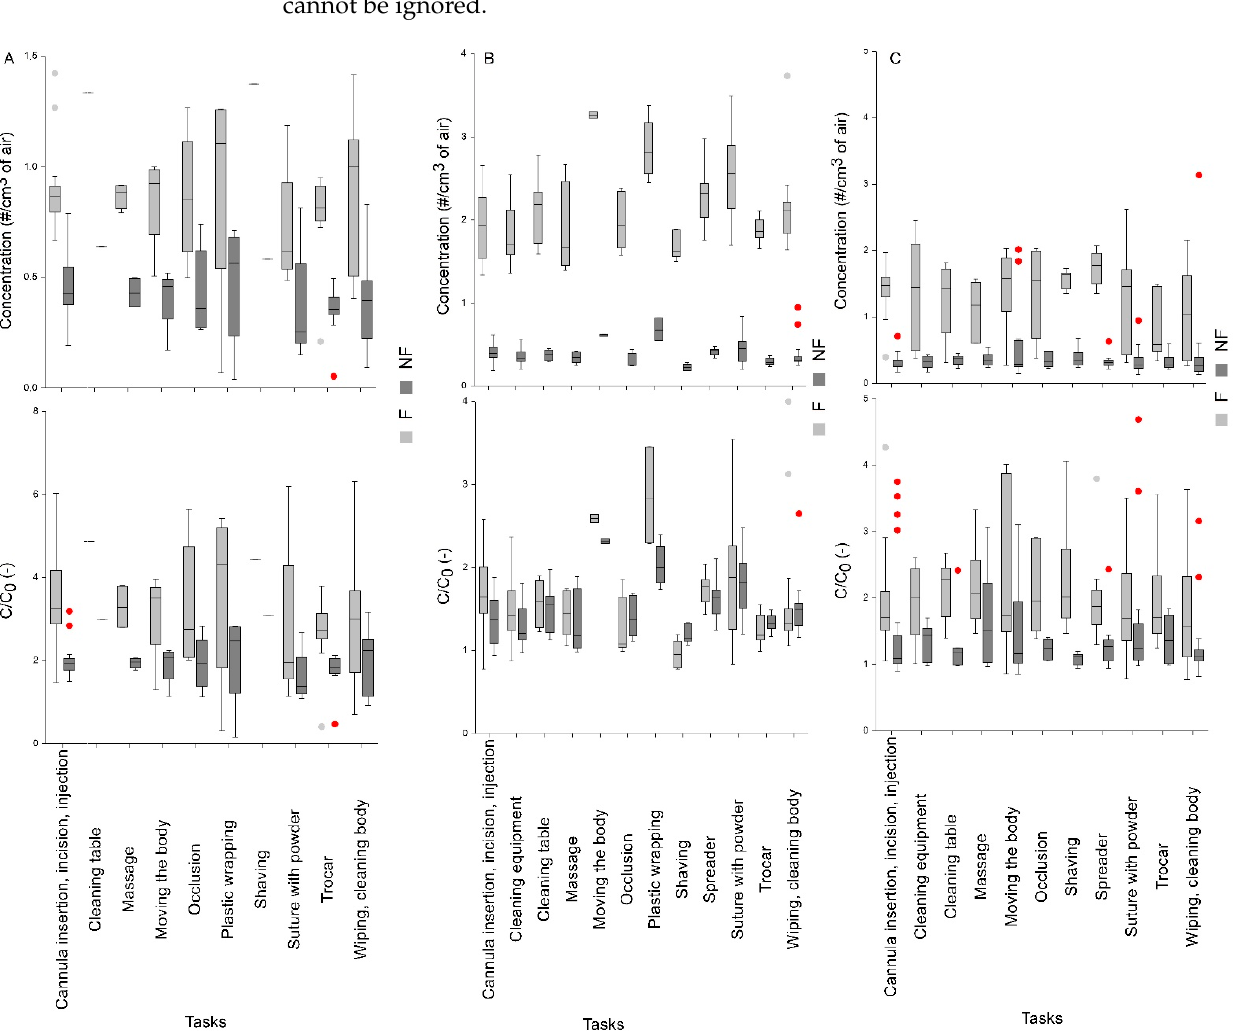
Figure 4. Concentration (red) and emission factor (gray) of biological/fluorescent (F) and non-biological/non-fluorescent (NF) particles, by task, ( top ) for lab A, ( middle ) for lab B, and ( bottom ) for lab C. (C: Concentration and C 0: baseline concentration).